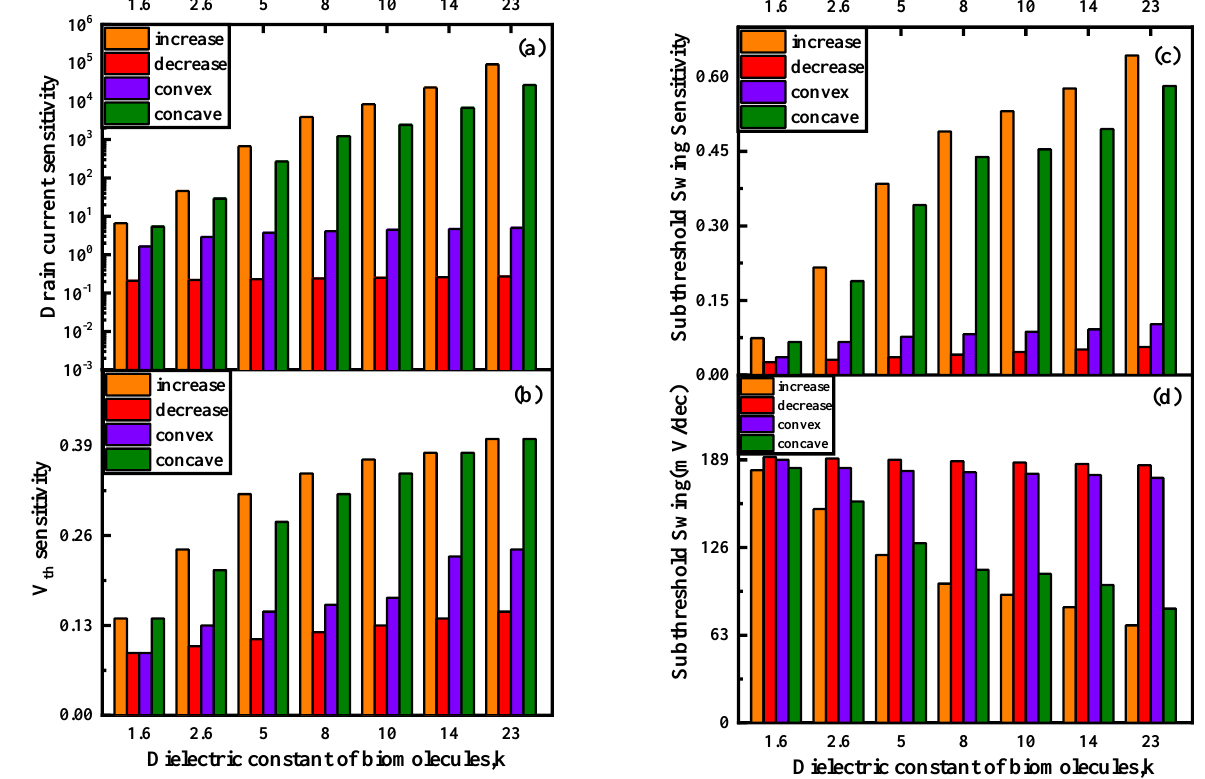
Figure 9. ( a ) Drain current sensitivity, ( b ) V th sensitivity, ( c ) subthreshold swing sensitivity and ( d ) subthreshold swing of DM − SSTGTFE biosensors for different k value and distribution at V d = 0.5 V, V g = 1 V and t c = 5 nm.